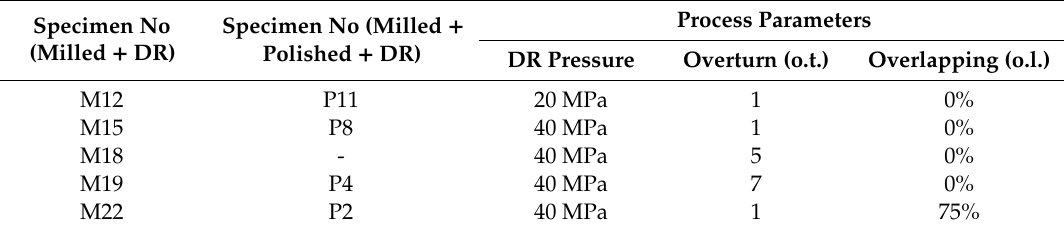
Table 3. Experimental design—DR process